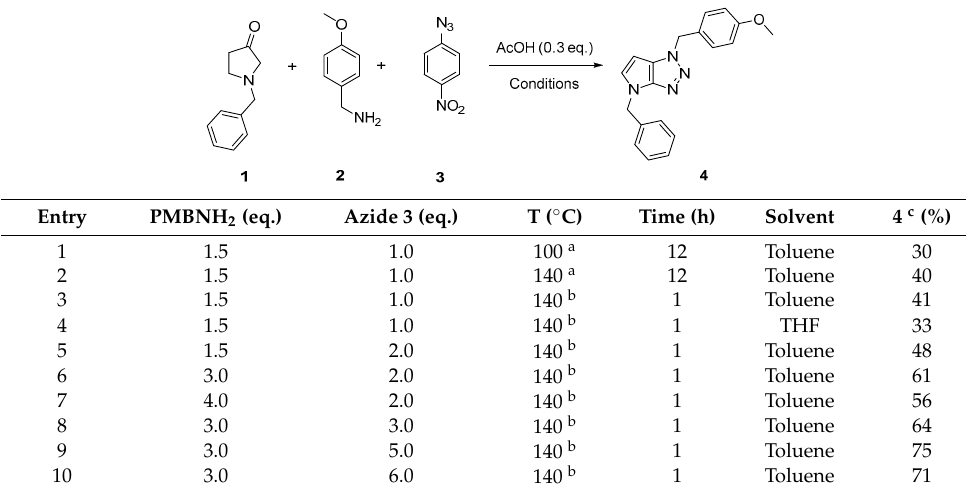
Table 1. Optimization of conditions for the formation of 4 .